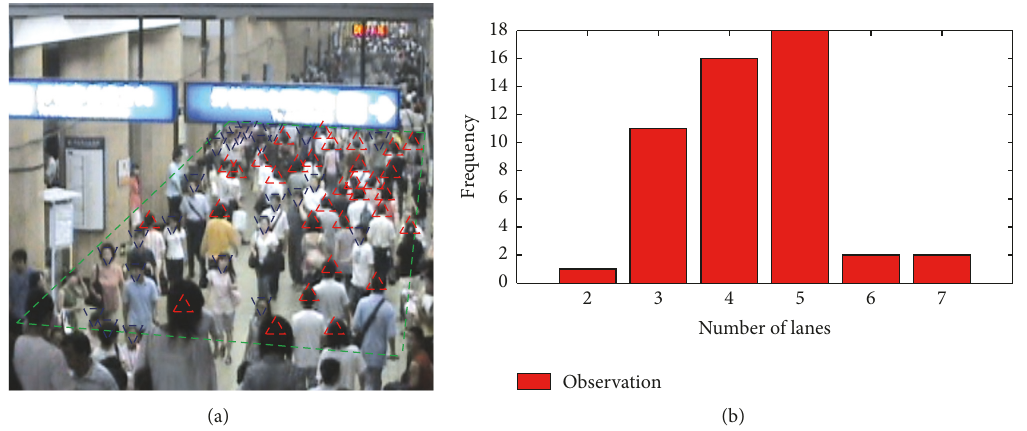
Figure 14: The actual lane-formation situation. (a) is the video screenshot of lane formation. (b) is the plot of the frequency of number of lanes. The width of the observation area is 8 m, the length of the observation area is 15m, and the density of the observation area is about 0.38–0.56 p / m 2 . We take 50 screenshots randomly from the video and count the number of the lanes; the results are shown in (b).